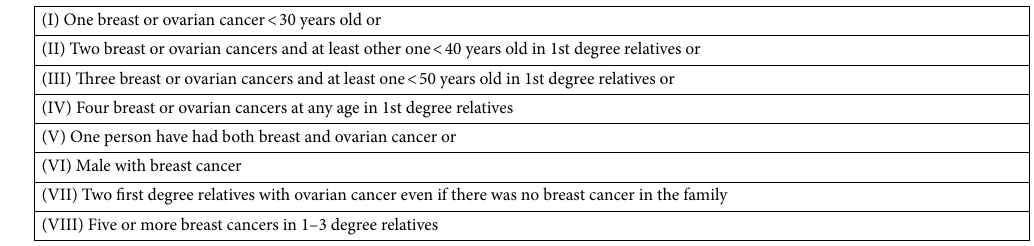
Table 1. Family factors related to high risk for breast cancer in the